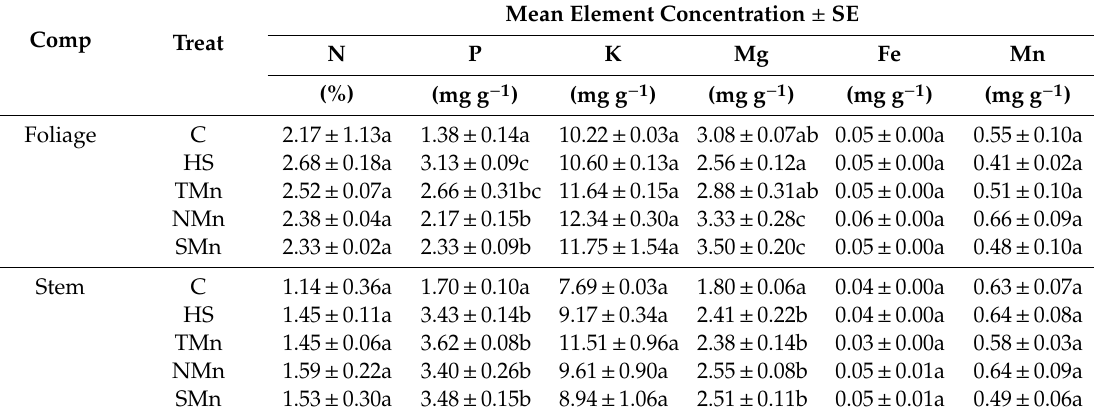
Table 5. E ff ect of manganese fertilization treatments 1 (Treat) on the mean 2 elemental content